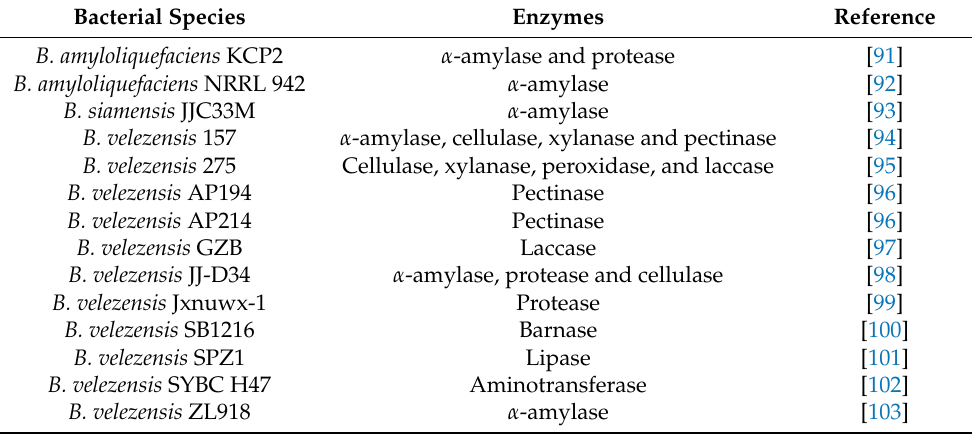
Table 4. Various types of enzymes produced by members of the operational group Bacillus amyloliq- uefaciens